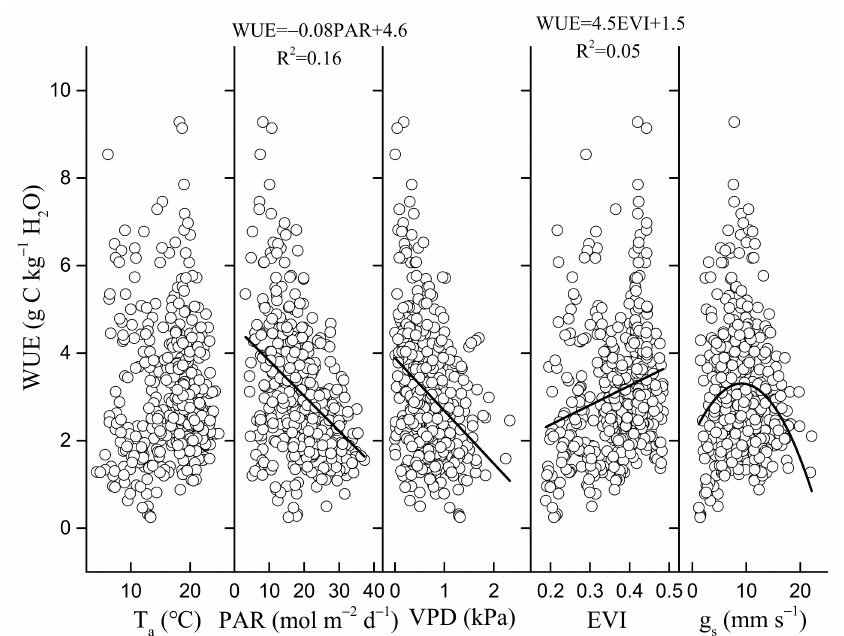
Figure 12. Relationships between daily water use efficiency (WUE) and daily environmental factors (T a , PAR, VPD) and biological factors (EVI, midday g s ) in all of the growing seasons from 2017 to